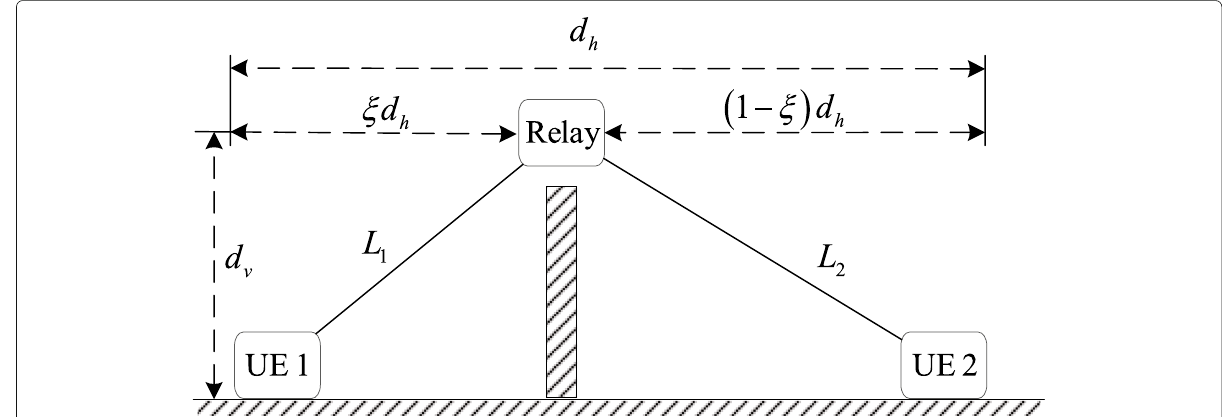
Fig. 2 The location of UAV-enable two-way relay system